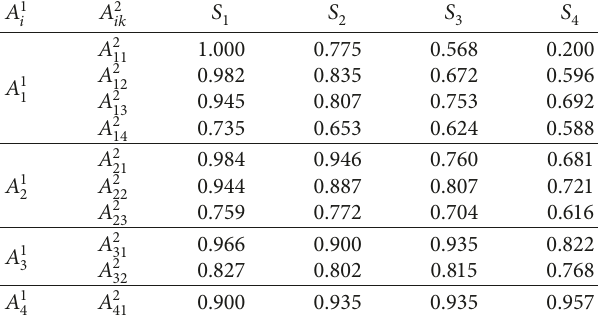
S t . j in time 2